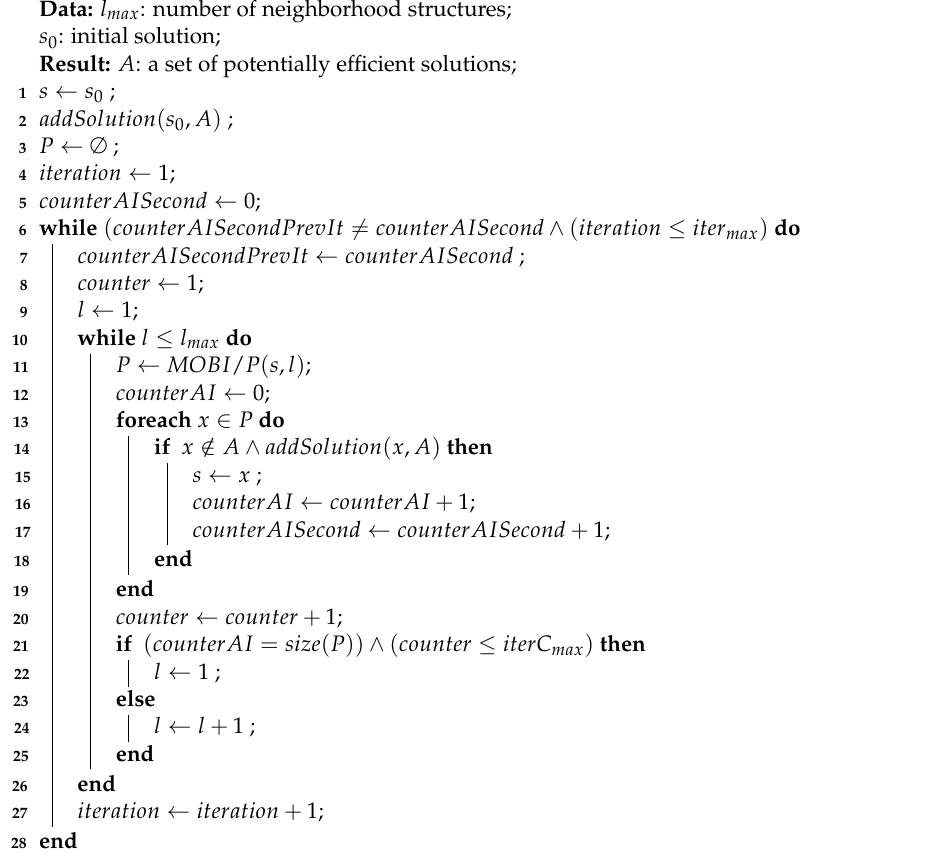
Algorithm 3: Multi-objective VND based on Pareto Dominance